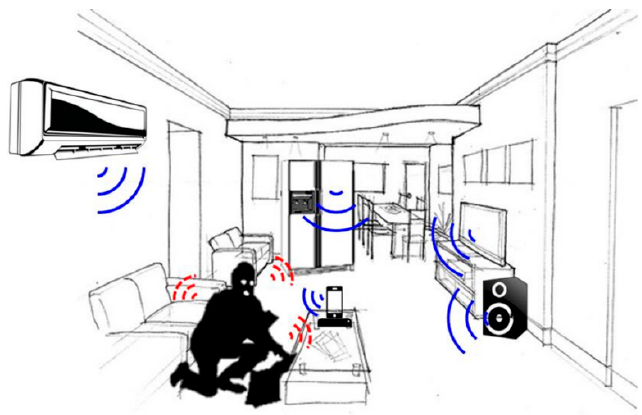
Figure 1. Conceptual illustration of an active localization system based on acoustic sensors in home appliances.